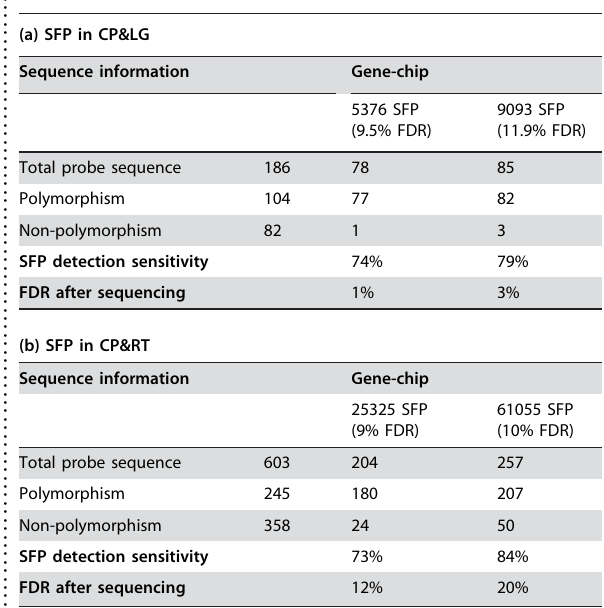
Table 4. Nature of polymorphisms and detection sensitivity of Table 3. Verification of gene-chip predicted SFPs by